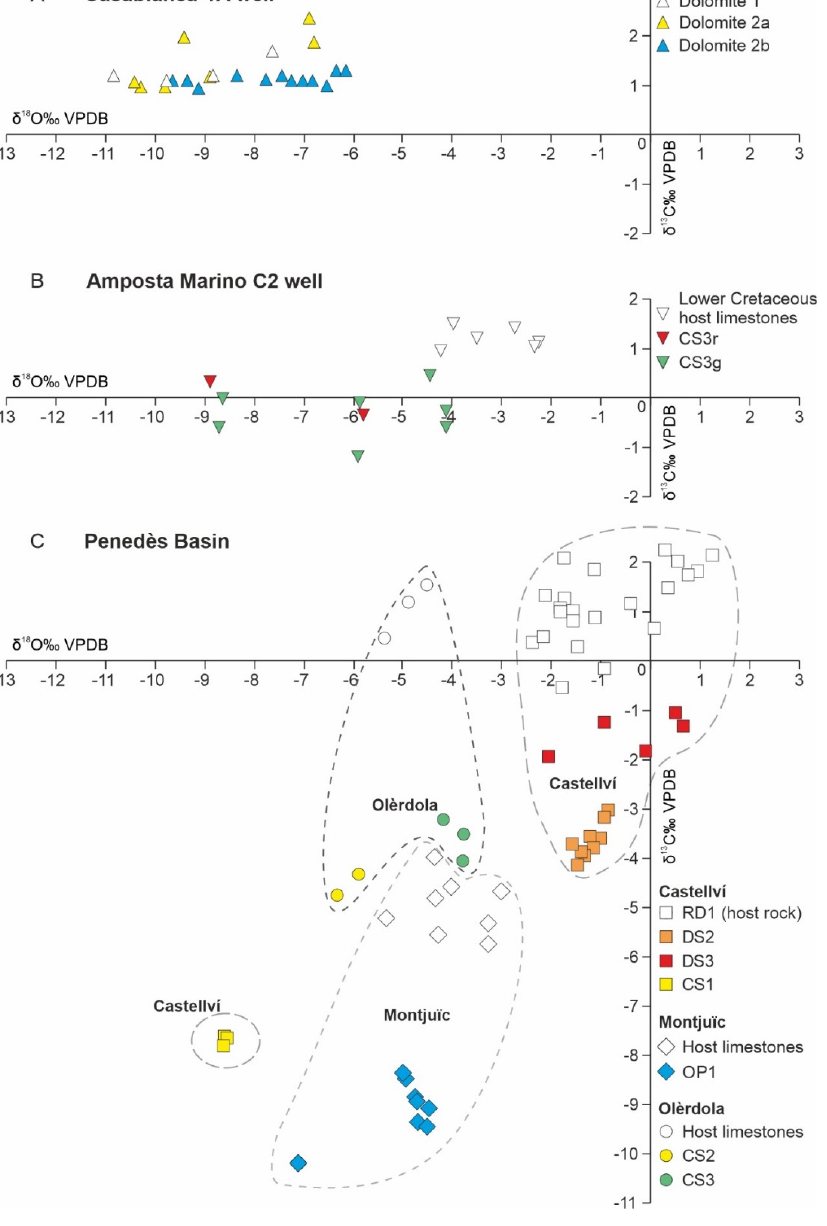
Figure 12. δ 18 O vs. δ 13 C of the karst fills and host carbonates in the Casablanca and Amposta oil wells and in the Pened è s